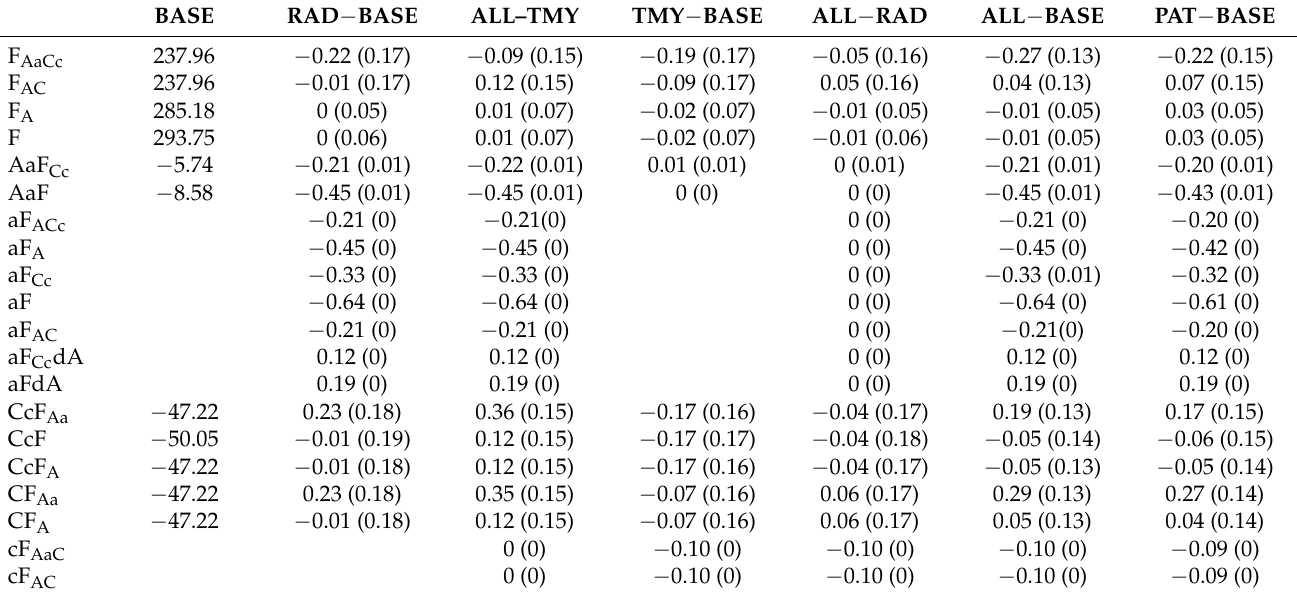
Table A1. Global annual means of the variables listed in Tables 1 and 2. The standard deviations (in brackets) are calculated from the difference of each year for 10 years. All values are in the unit of W m − 2